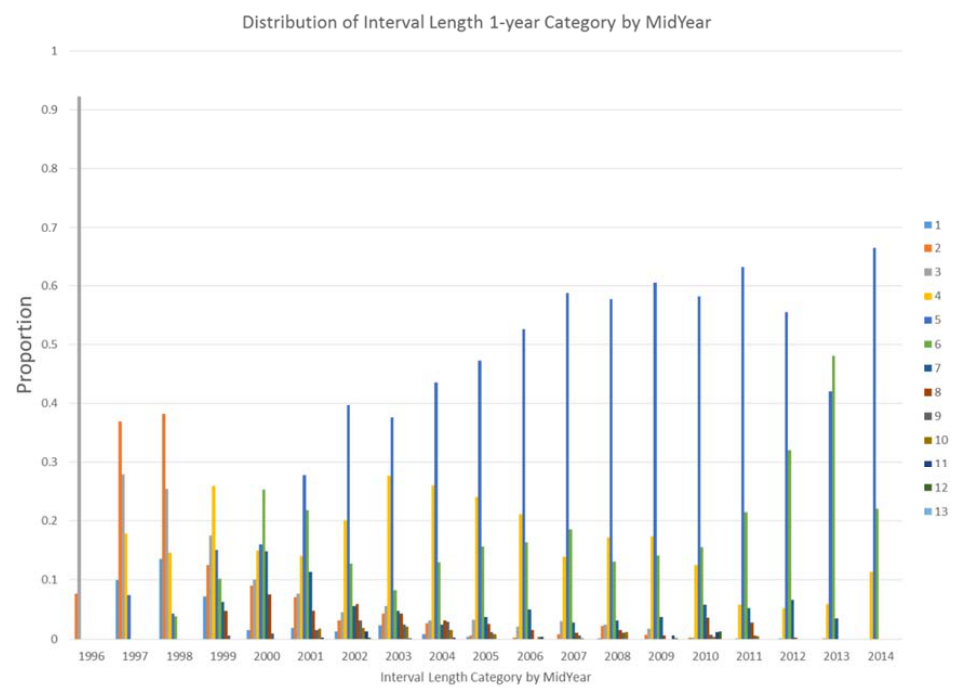
Figure 2. The interval length distribution of one-year categories (of one to 13 years) in FIADB for 34 States in the United States, by MidYear ranging from 1996 to 2014.